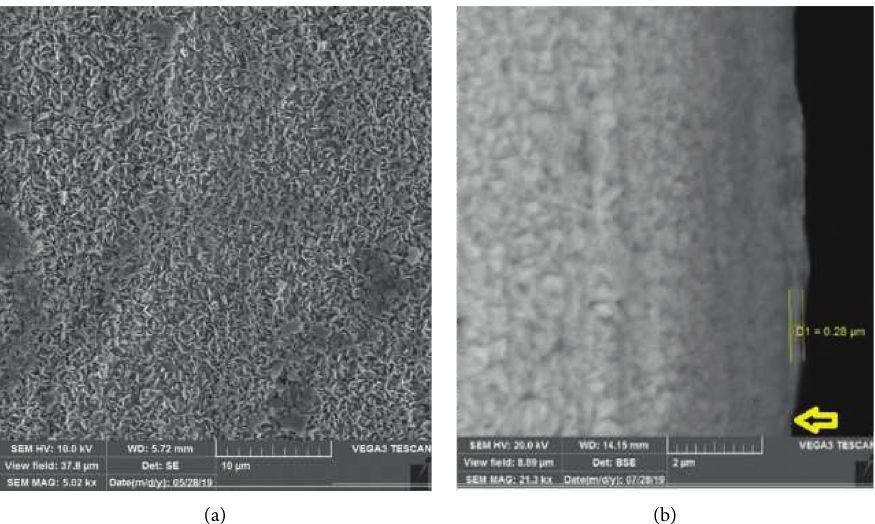
Figure 2: (a) The Zn-coated SS orthodontic wires. The uniform distribution of Zn on the wire can be observed (magnification: 5.02kx). (b) Backscatter waves of SEM showed the thickness of Zn on the SS orthodontic wires. This is due to the difference in electron reflection. The mean thickness of Zn was 0.28 µ m. There was no Zn layer on the bottom of the wire because it was covered with a plastic tape (magnification: 21.3kx).